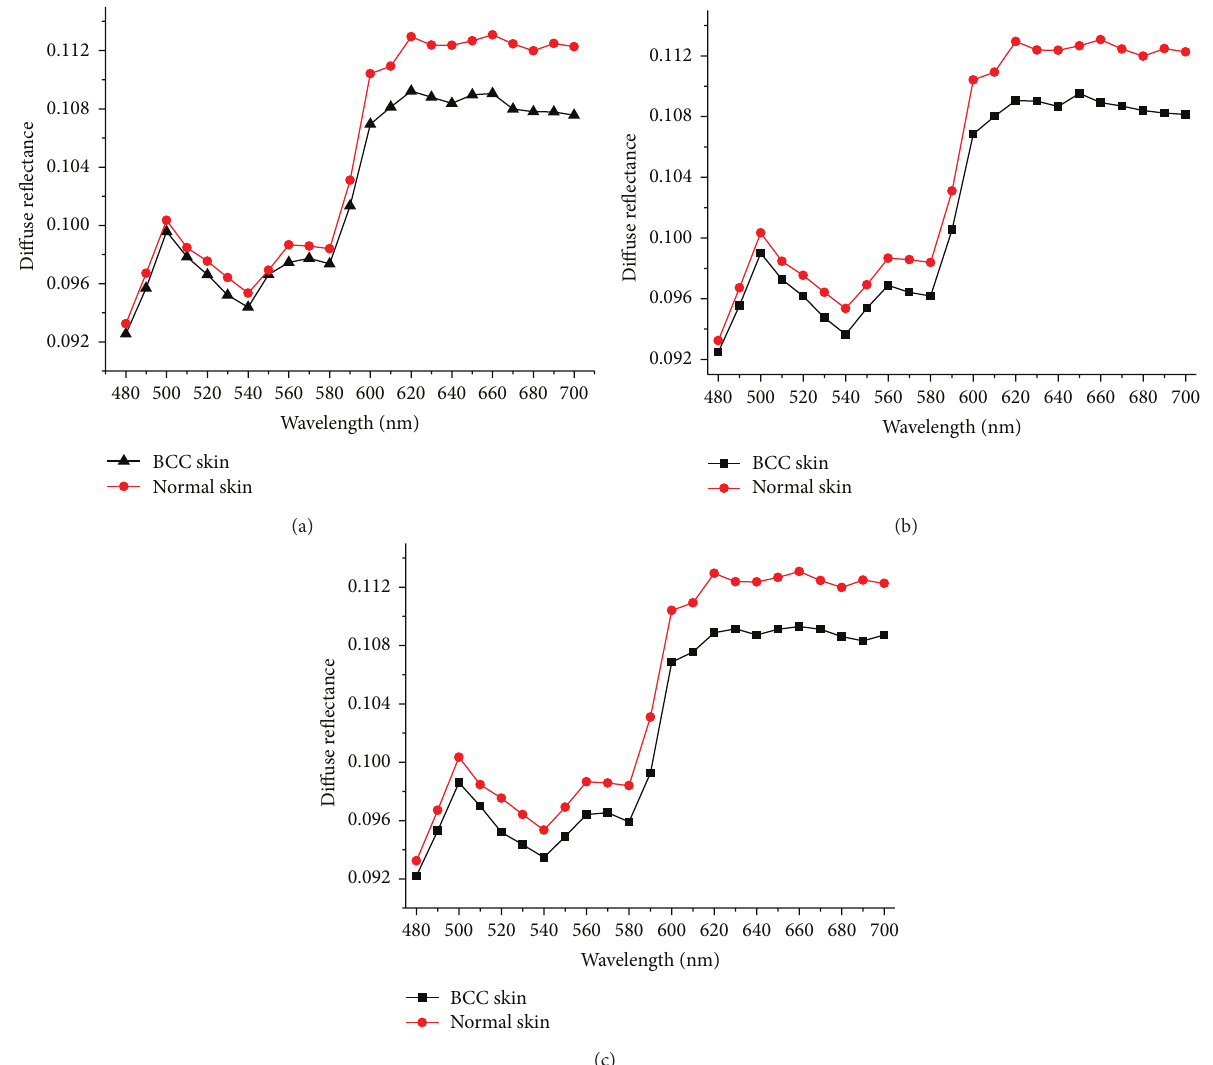
Figure 4: (a) Monte Carlo calculated reflectance spectra of BCC skin. (b) Monte Carlo calculated reflectance spectra of BCC skin. (2% blood factors added to the BCC layer). (c) Monte Carlo calculated reflectance spectra of BCC skin. (5% blood factors added to the BCC layer).